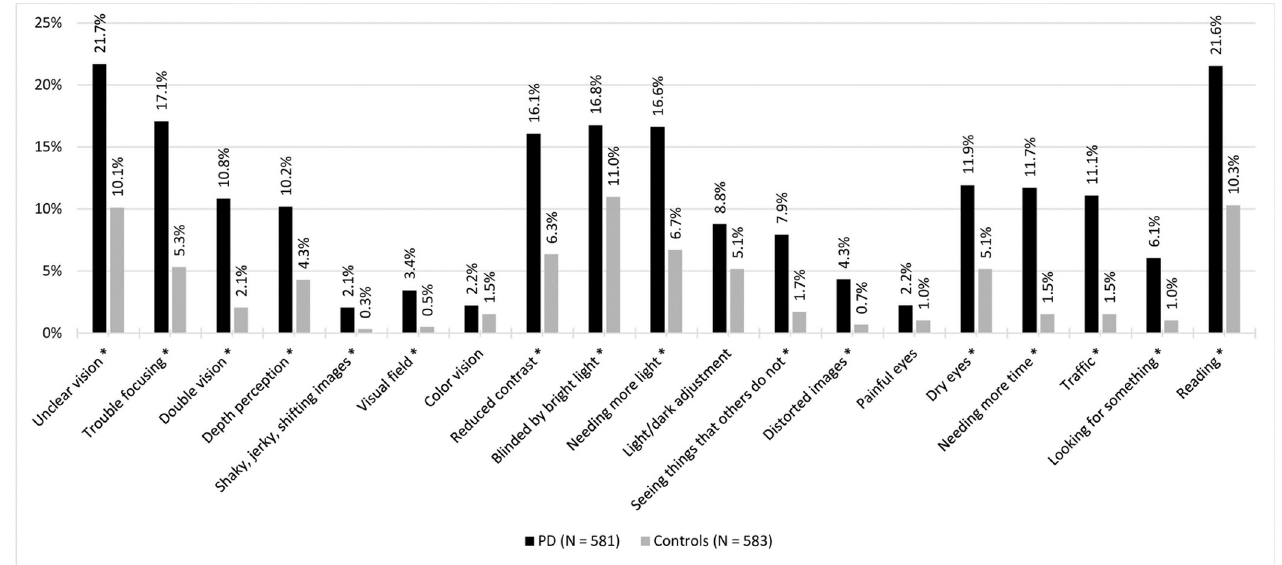
Fig 1. Prevalence of visual complaints reported ‘often/always’ by people with Parkinson’s disease and age-matched controls. * = significant difference between the groups ( α < .008).